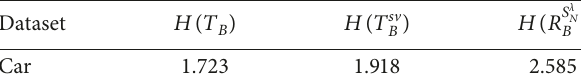
T sv R S λ N B , B B , and